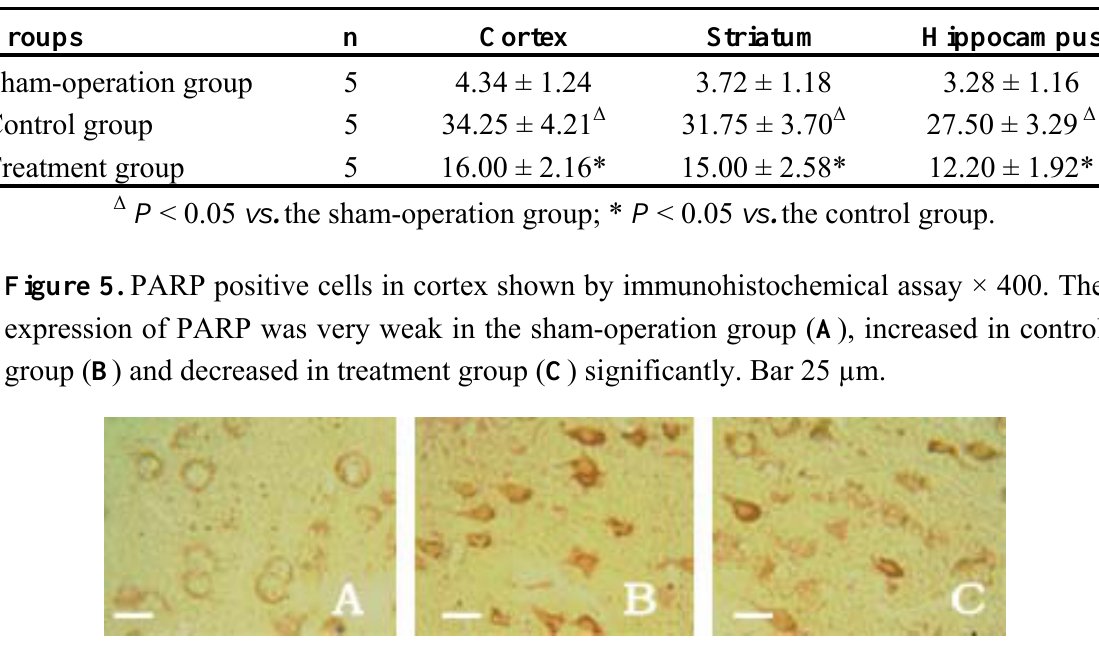
Table 4. The number of PARP positive cells ( x ±